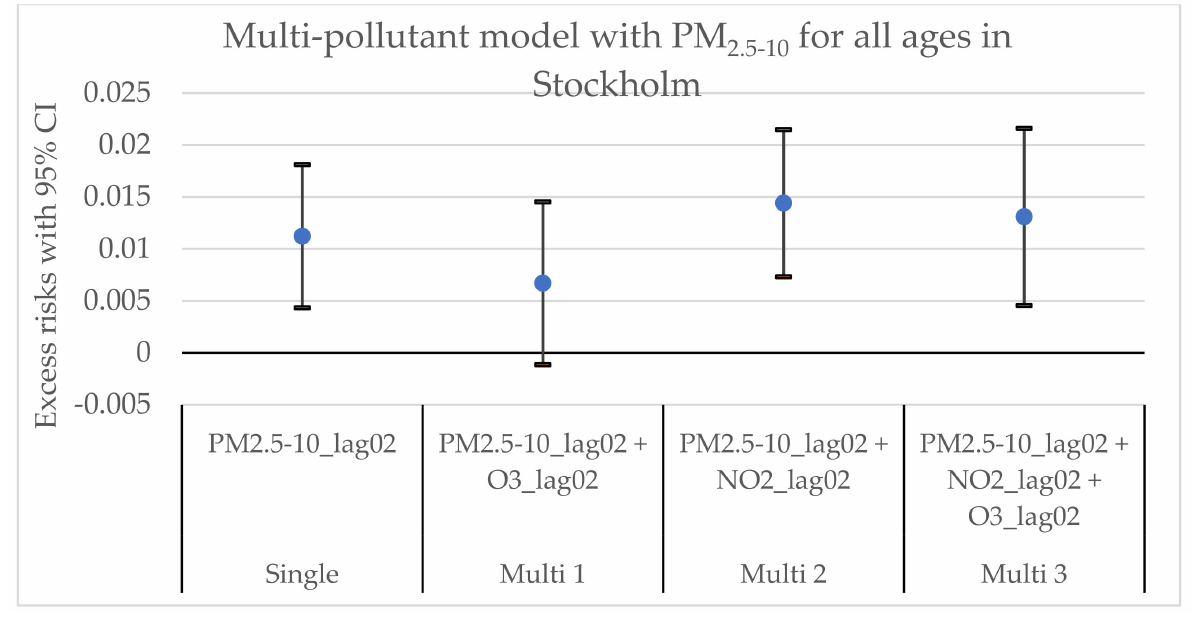
Figure A2. Multi-pollutant models of the estimated change in daily mortality in all ages (with 95% CI) for an IQR increase in the concentration of PM 2.5–10 (lag02) in Stockholm. From left to right: a single-pollutant estimate of PM 2.5–10 (Single), PM 2.5–10 adjusted for O 3 (Multi 1), PM 2.5–10 adjusted for NO 2 (Multi 2), and PM 2.5–10 adjusted for both NO 2 and O 3 (Multi 3).